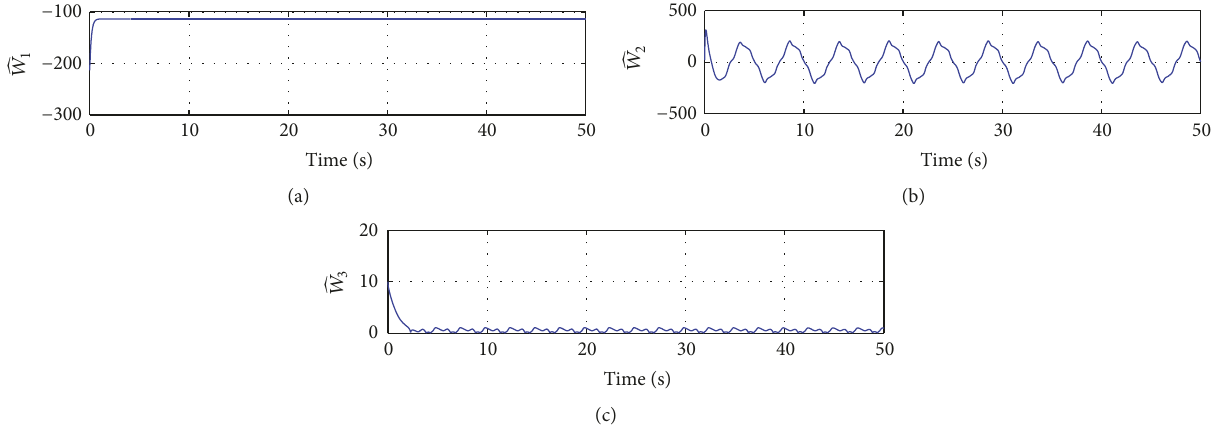
̂𝑊 1 ; (b) the trajectory of